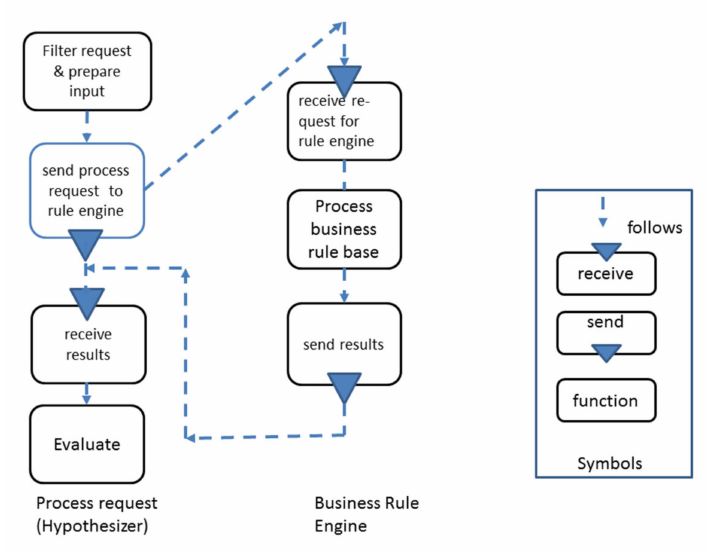
Figure 16. Integration of rule